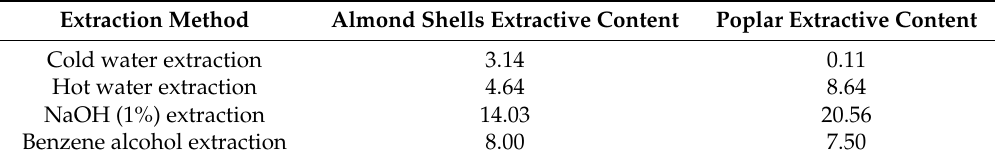
Table 2. Extractive content of different extraction methods (wt %).